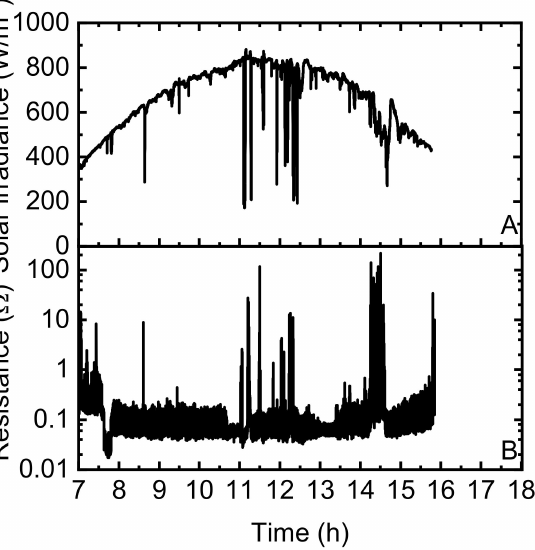
Figure A7. Varied resistances with the PTC lamp connected in a series with the feed pump in the PV-membrane system, indicating ( A ) solar irradiance (W/m 2 ) and ( B ) resistance ( Ω